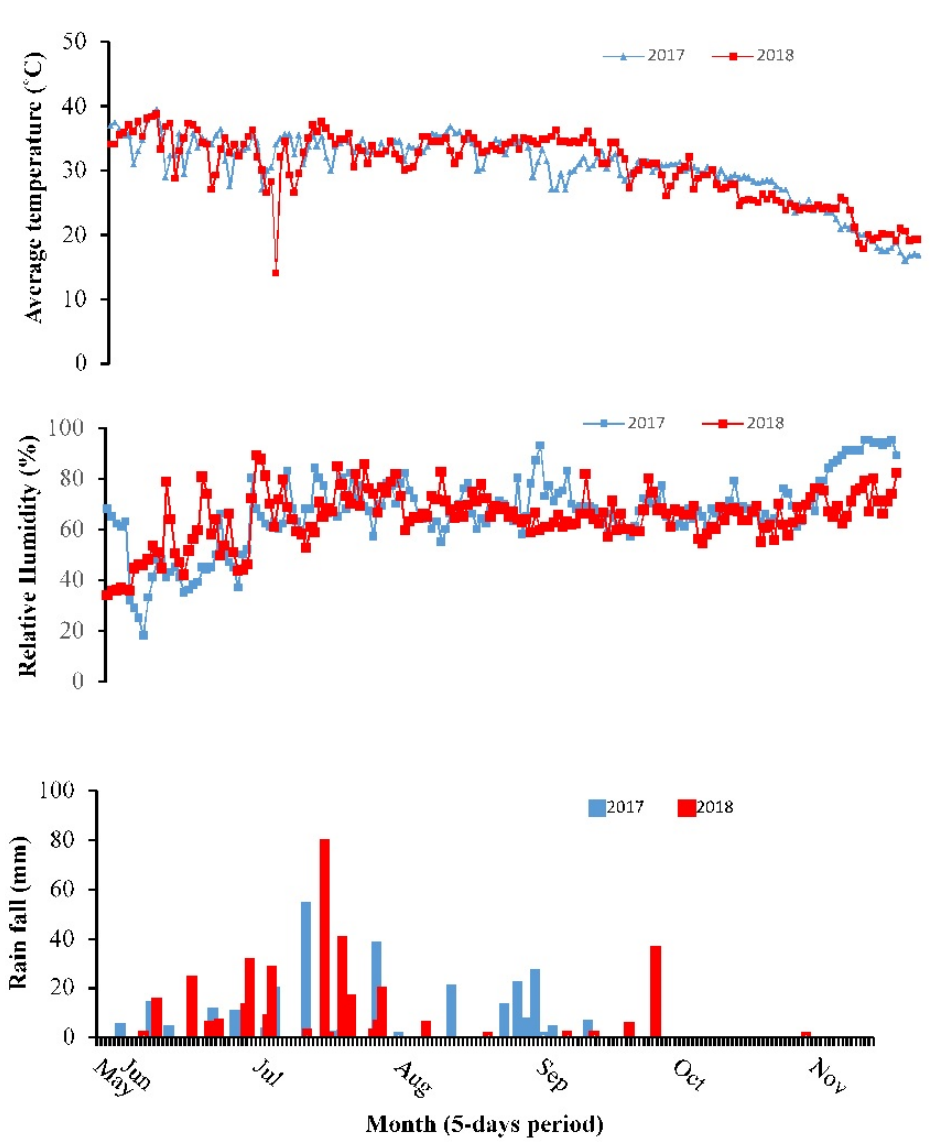
Figure 1. Weather data for the experimental site during the cotton season of 2017–2018.